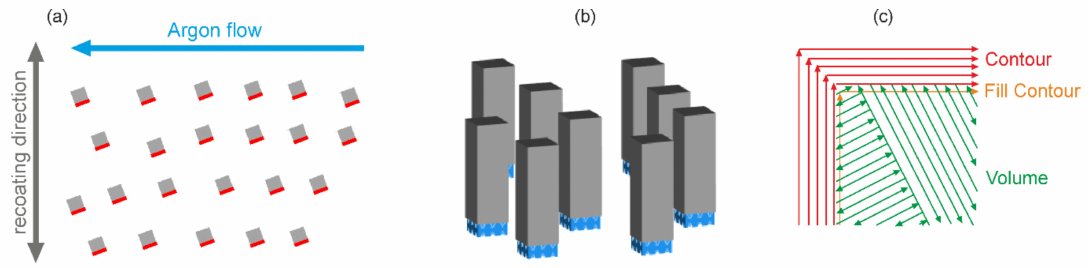
Figure 1. ( a ) Sample positions on the base plate; red marked are the sample sides, which were investigated in this study; ( b ) side view of the specimens (5 × 5 × 15 mm 3 ), which were printed on 2 mm block supports; ( c ) example for a typical scan pattern used in this study consisting of 5 contour lines, 1 fill contour, and volume